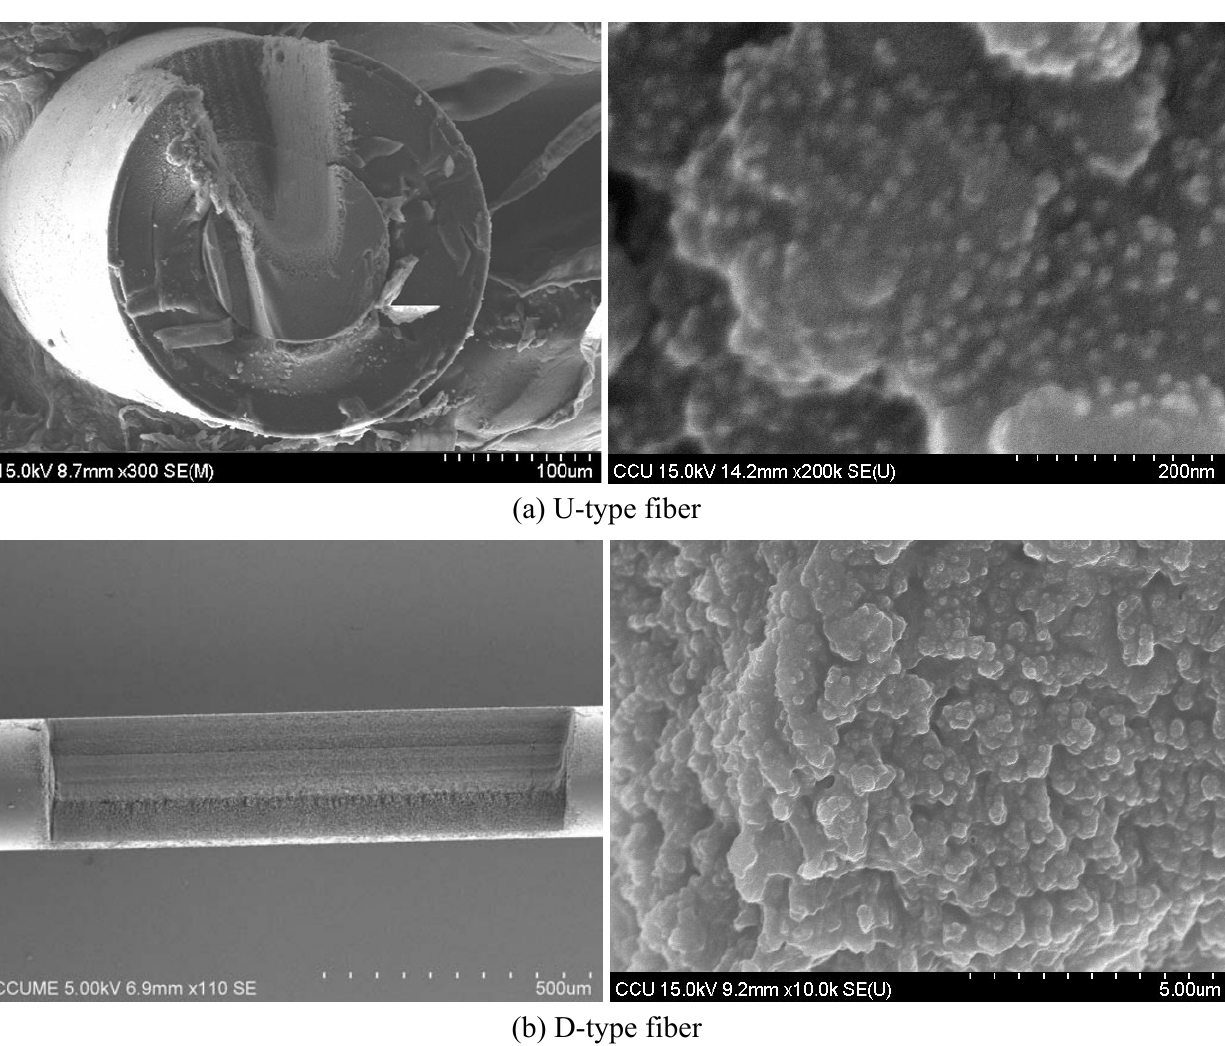
Figure 10. SEM images of (left) the optical fiber fabricated by the femtosecond laser and (right) its exposed surface after modification by gold nanoparticles for (a) U-type and (b) D-type